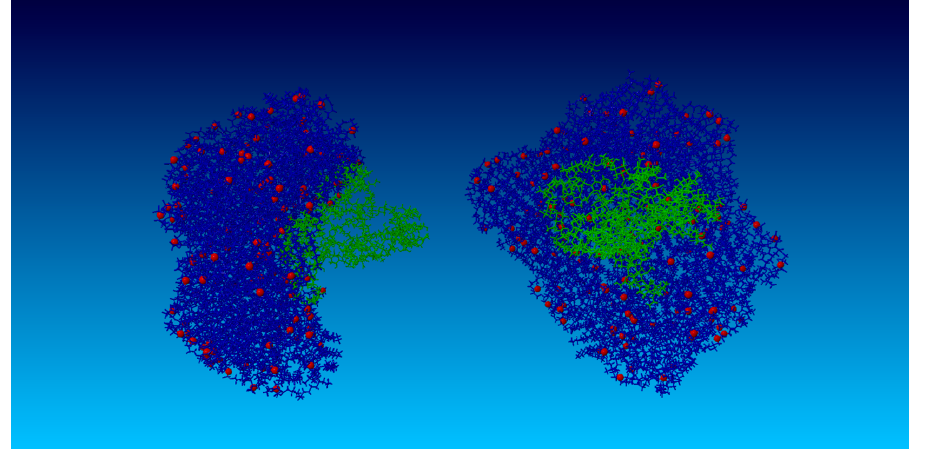
Figure 16. Simulation snapshot of the HA chain ( Left ) adsorbed into a DPPC vesicle ( Right ). The images are depicted with 150 lipids. HA molecules are green and DPPC molecules are blue. Red depicts oxygen atoms localized at hydrophilic DPPC head groups.